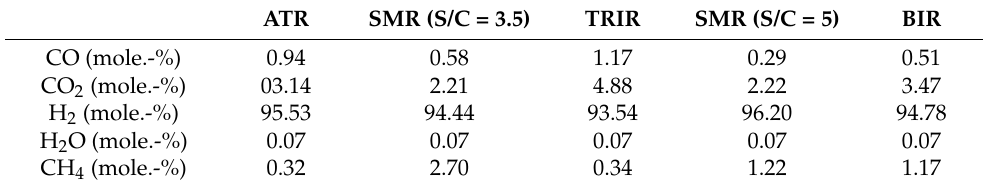
Table 10. Clean gas output of Selexol process.